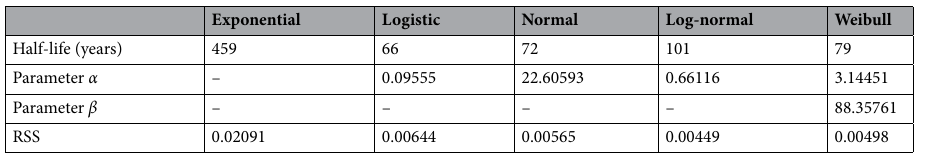
Table 1. Parameters of lifetime functions of wooden houses. The half-life values and the other parameters correspond to the estimations shown in Fig. 1. “RSS” denotes the least residual sum of squares between the actual and estimated values for each lifetime